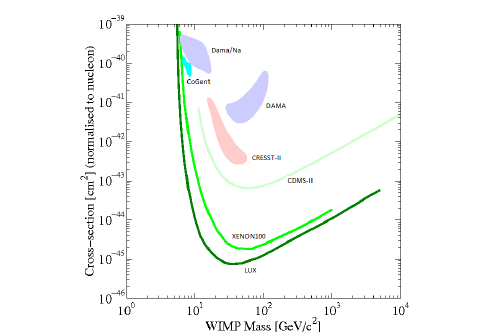
Figure 4: Status of experimental direct search for WIMPs. The 68% CL region of possible positive detec- tion are shown as filled area, while solid line represents 95% CL upper